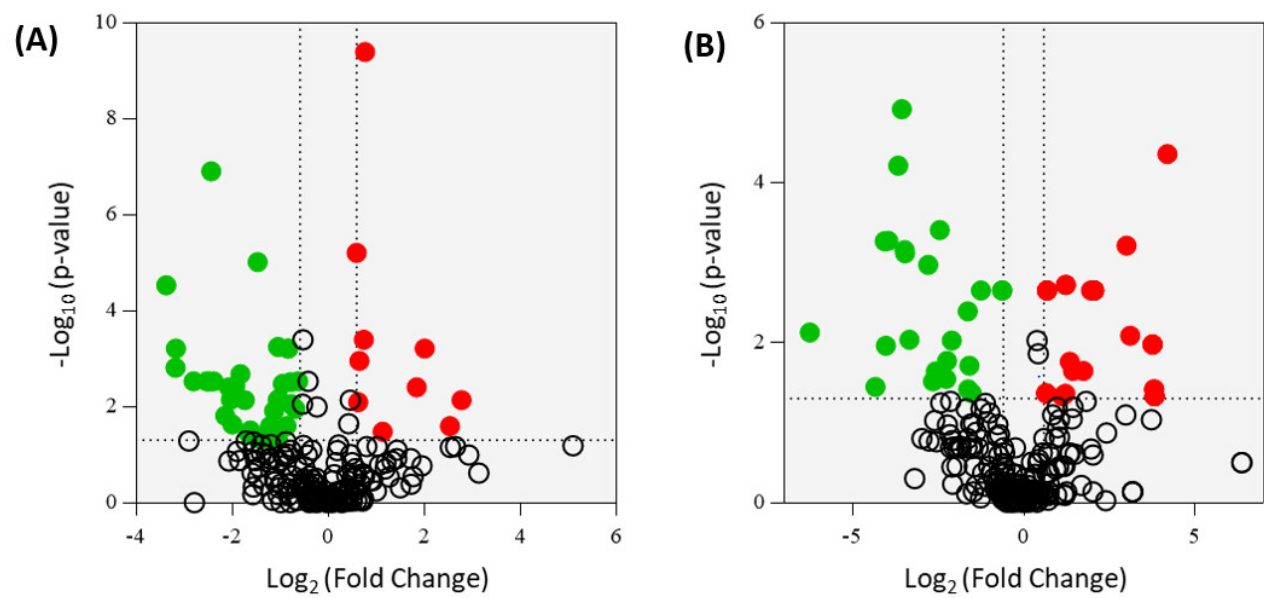
Figure 9. Volcano plots of the significant metabolites from central carbon metabolism ( A ) and untargeted metabolites ( B ) using a fold change (FC) threshold of ≥ 1.5 or ≤ 0.66 and a p -value of ≤0.05. For a full list of significant metabolites, see Supplementary Information, Tables S2 and S3. The red circles are the significant metabolites that were upregulated in the ferrets infected with the SA01 isolate relative to the VIC01 isolate. The green circles are the metabolites that were downregulated in the SAC01 isolate relative to the VIC01 isolate.